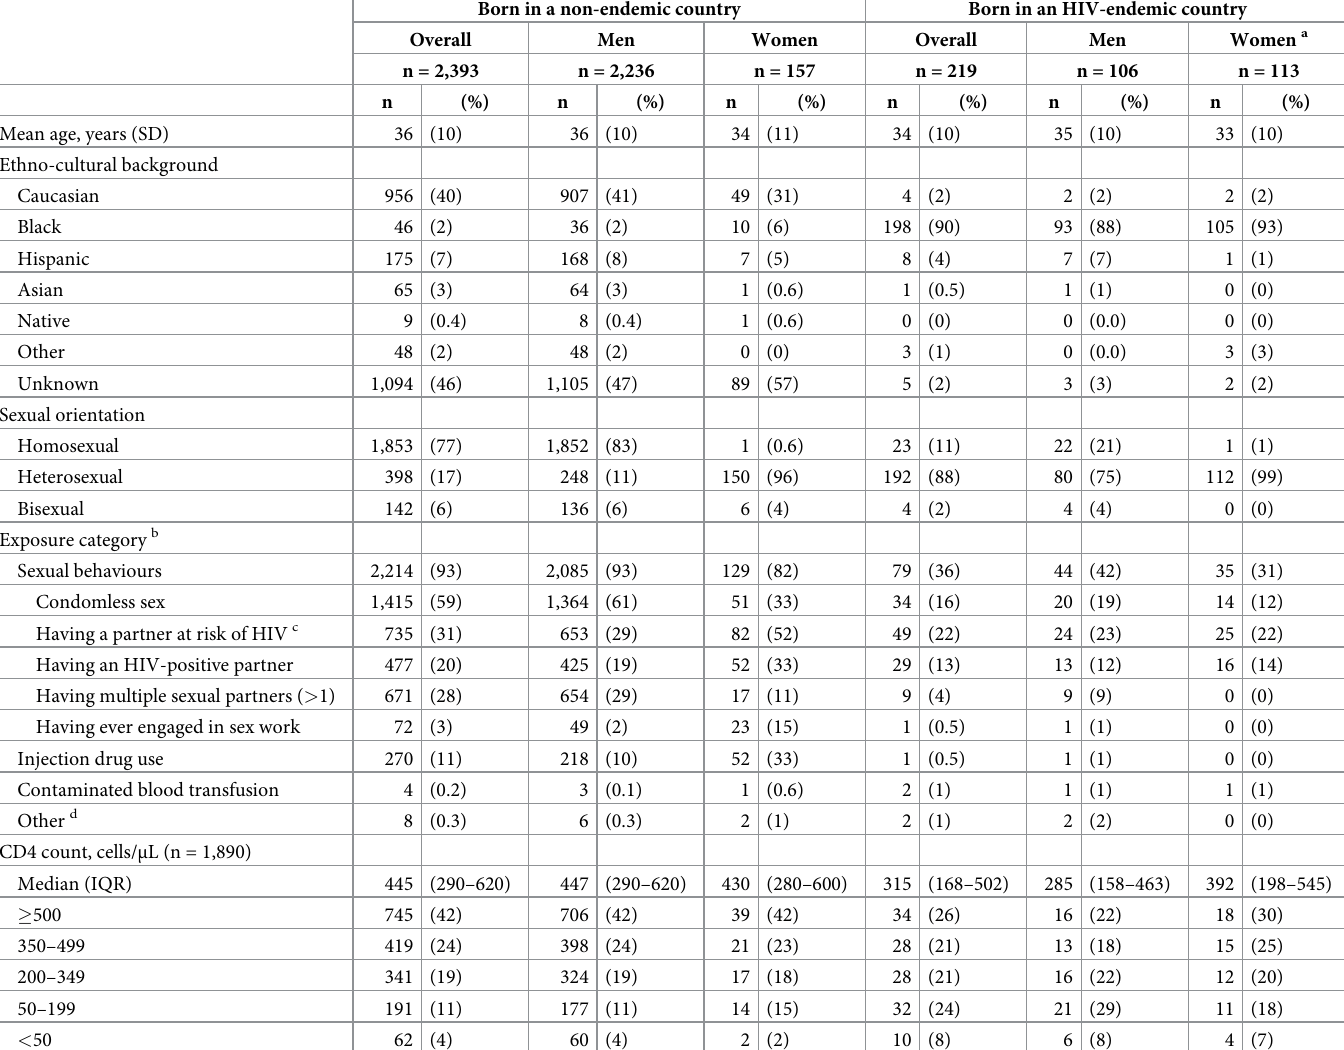
Table 2. Characteristics of patients at HIV diagnosis among participants to the HIV-positive cohort at the Clinique médicale l’Actuel in Montre´al (Canada), strati- fied by origin and gender (n = 2,612), 1995–2019. Born in a non-endemic country Born in an HIV-endemic country Overall